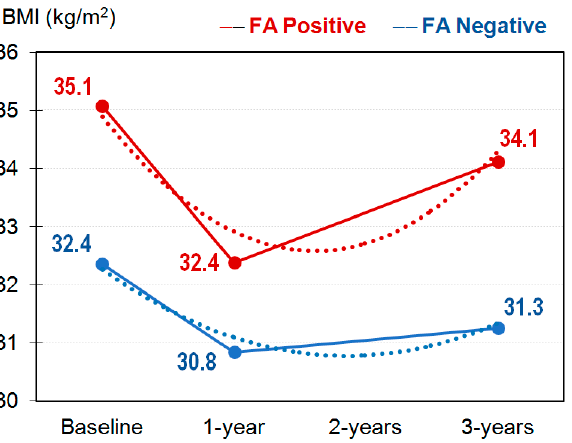
Figure 1. Evolution of the BMI (kg/m 2 ) during the study. Note. Dash line: polynomial quadratic trend. Sample size: n = 434. trend. Sample size: n =